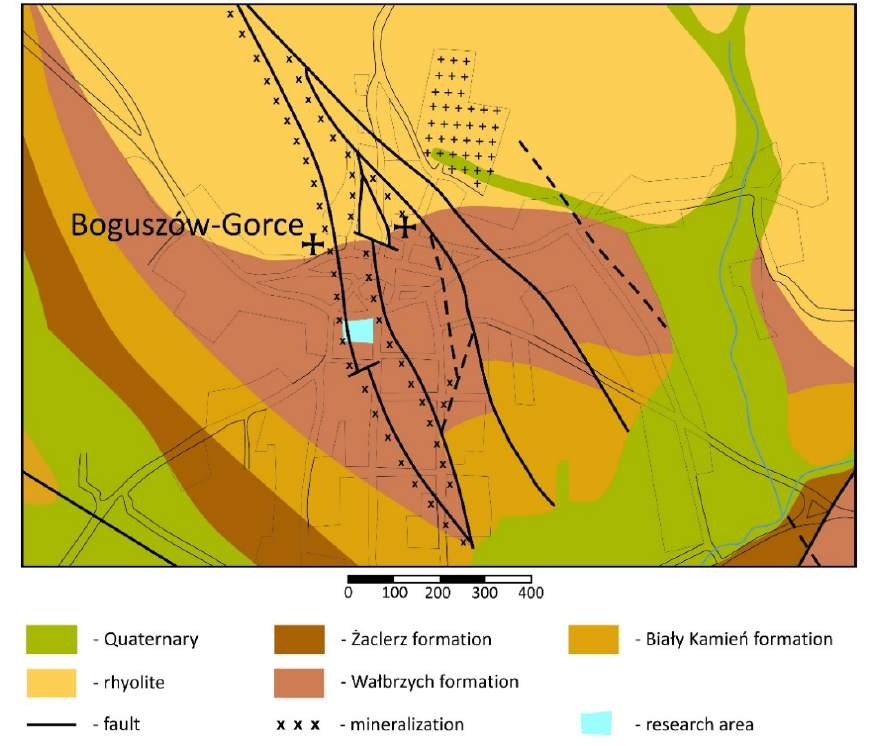
Figure 8. Simplified geological setting in Boguszów-Gorce area. In the fault zones, in the near-surface part of the rock mass, mineralization of silver ore occurs, while barite is observed at a greater depth. There are four zones in the city area. Two of them and partly the third one are mineralized, and the extreme southern one runs through the surveyed